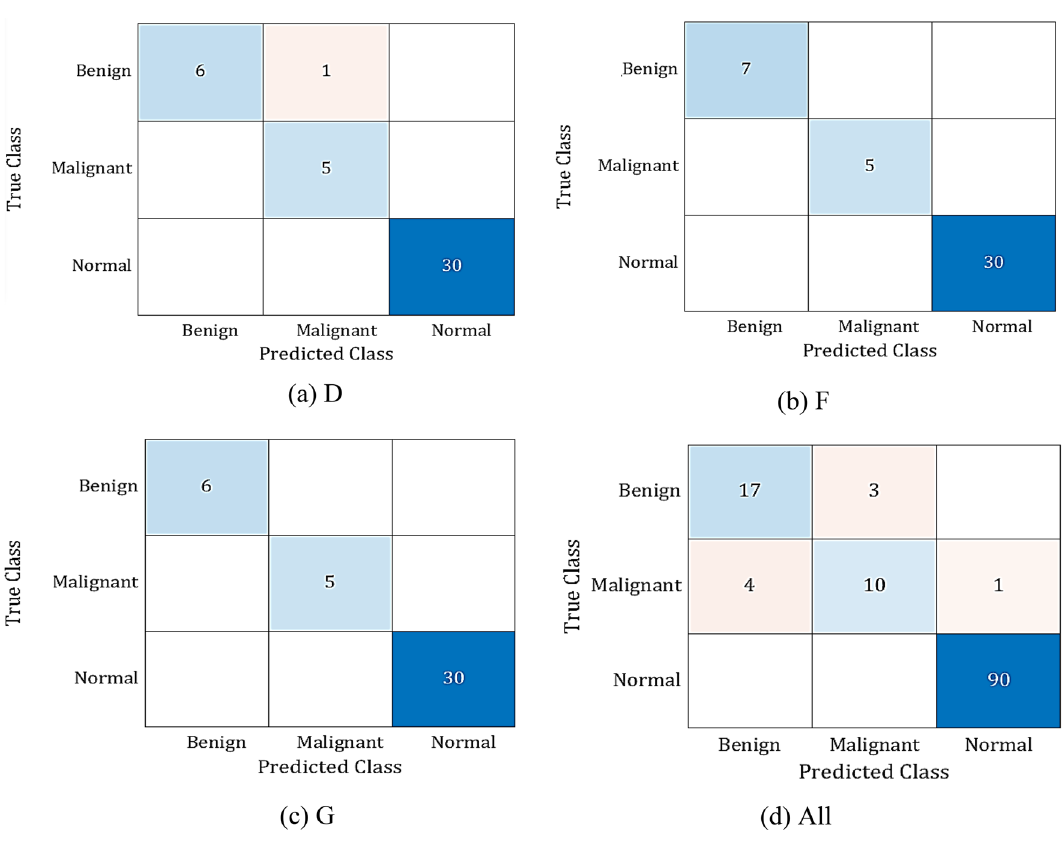
Figure 4. Confusion matrices of the proposed